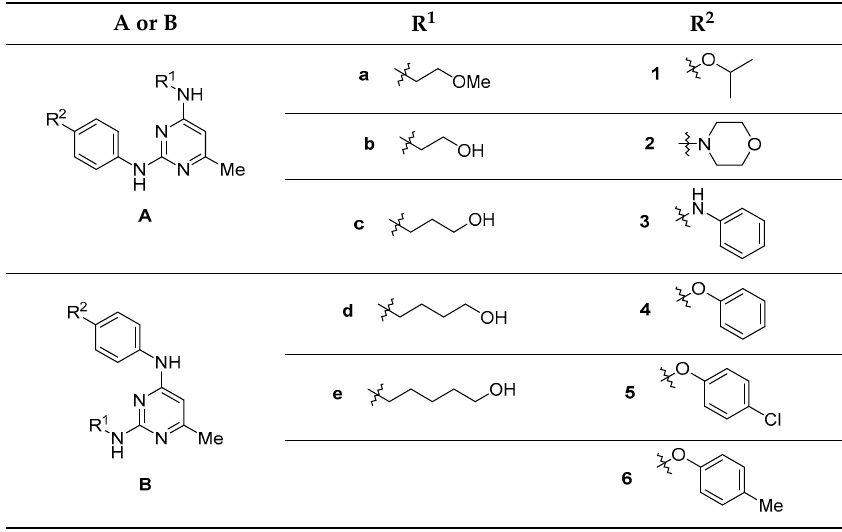
Table 1. Chemical structures of synthesized compounds.